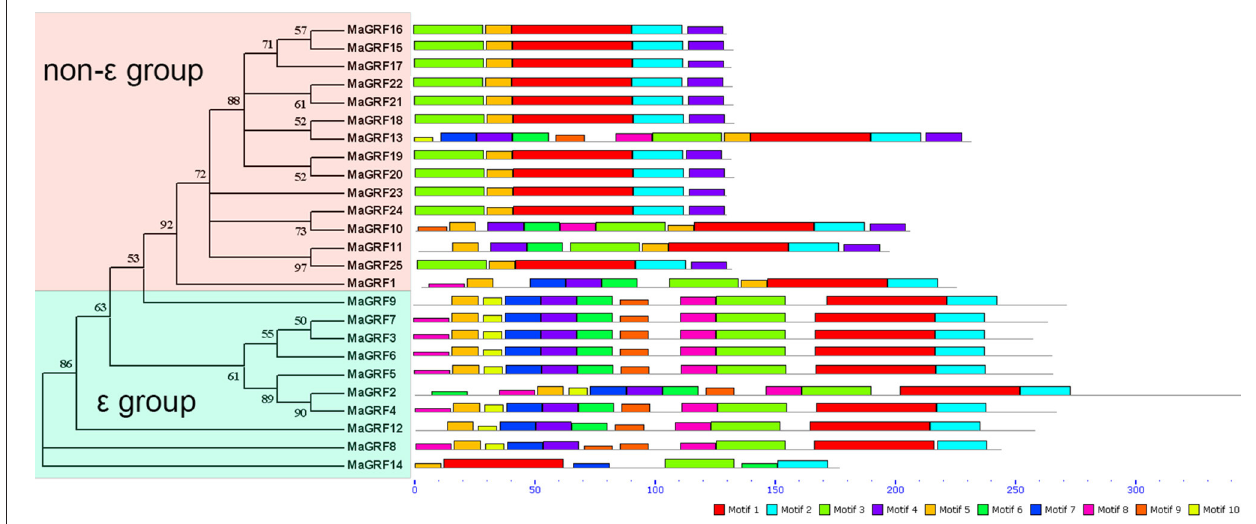
FIGURE 4 | The phylogenetic relationship and motif analyses of banana 14-3-3s. The neighbor-joining tree was created using ClustalX 2.0 and MEGA5.0 with amino acid sequences of banana 14-3-3s. Two groups are indicated with different color backgrounds. All motifs were identified by the MEME database with complete amino acid sequences of banana 14-3-3s. Lengths of motifs for each banana 14-3-3 protein were exhibited proportionally.